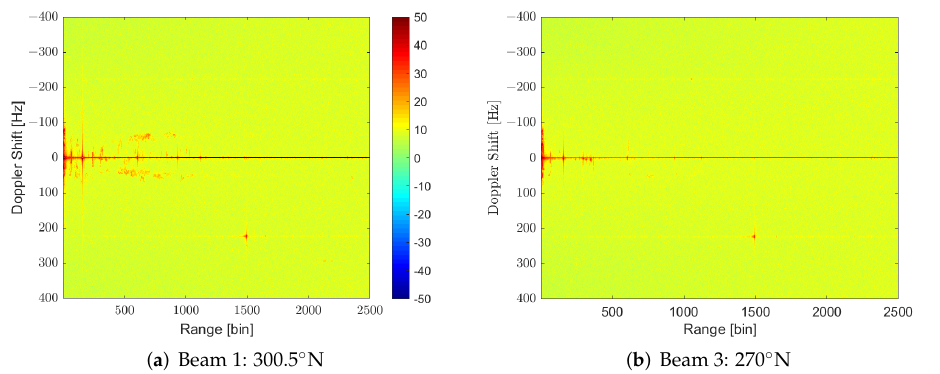
Figure 6. Cumulative of maxima of RD during the acquisition time for two orthogonal